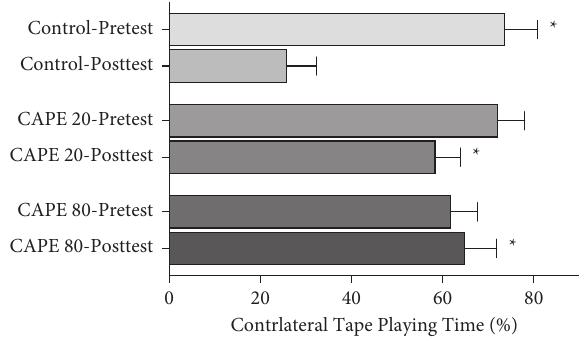
Figure 2: The ratio of contralateral lesion side (left side) tape playing time versus total playing time. Adhesive tape removal test results of control, CAPE 20, and CAPE 80 groups before (termed as pretest) and after (termed as posttest) 6-OHDA application.